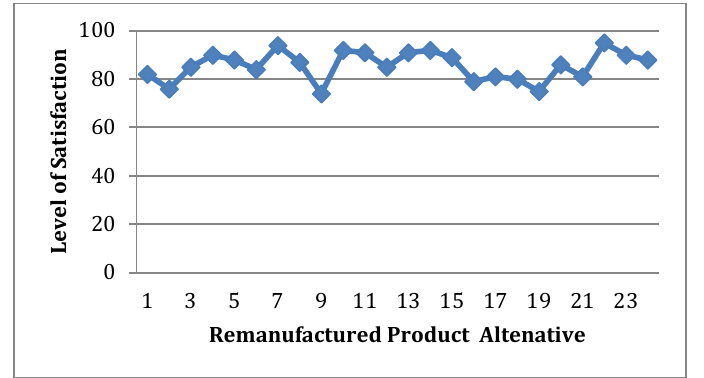
Figure 17: Remanufactured product alternative based level of satisfaction assessment